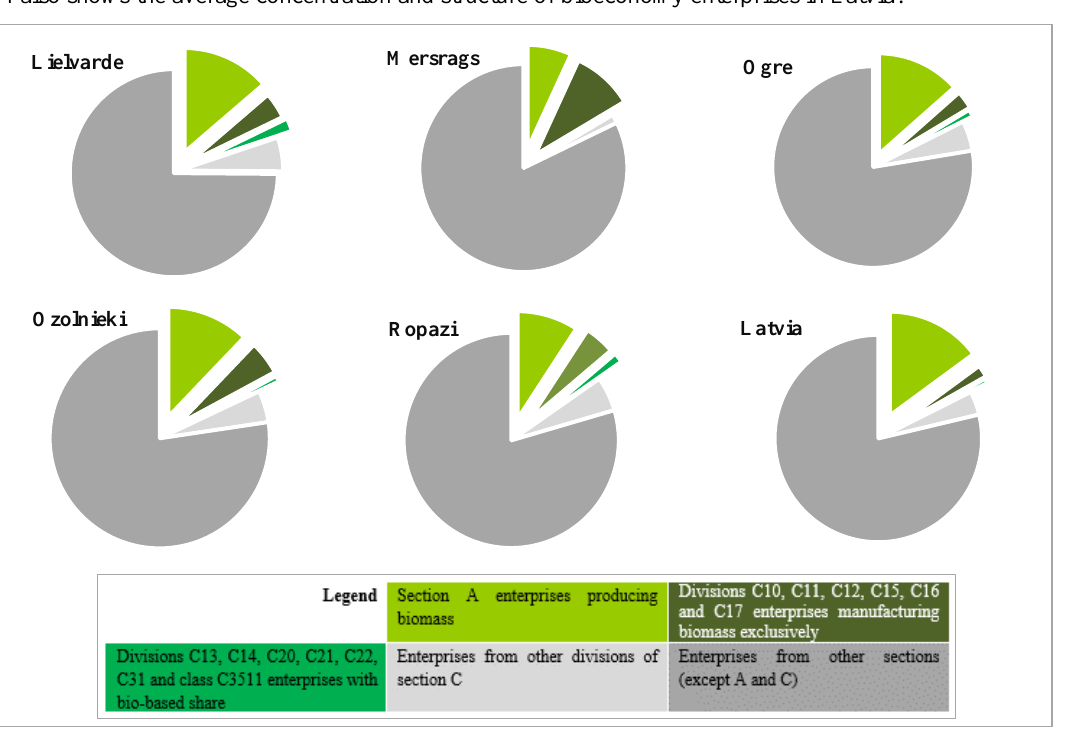
Figure 5. Distribution of divisions (according to the NACE Rev. 2 classification) by number of economically active enterprises of the market sector in the municipalities belonging to Group B in 2019, % TOP 5 industries in Group B municipalities were as